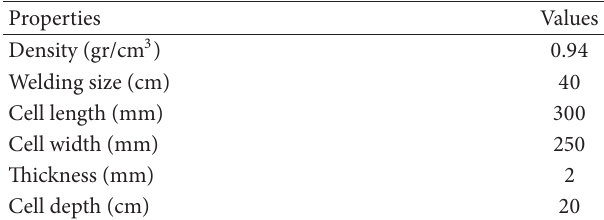
Table 4: Technical properties of geocell.